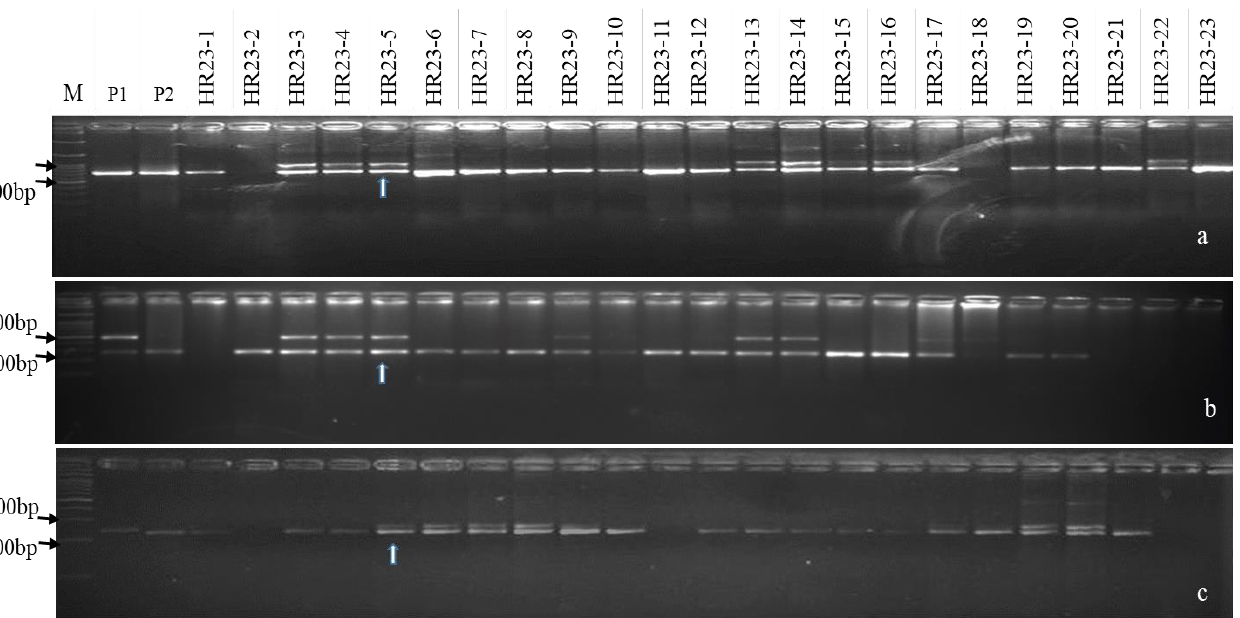
Figure 2. PCR amplification of BB resistance gene (s) in BC 1 F 1. ( a ) Amplicons of the Xa21 gene using pTA248 primer. ( b ) Amplicons of the xal3 gene using xal3prom primer. ( c ) Amplicons of the xa5 gene using RM122 primer; M, marker; P1, donor parent (IRBB66); P2, recurrent parent (HUR 917), Lanes 4–26 represent BC 1 F 1 plants; vertical arrows indicate a positive plant heterozygote for all targeted genes.